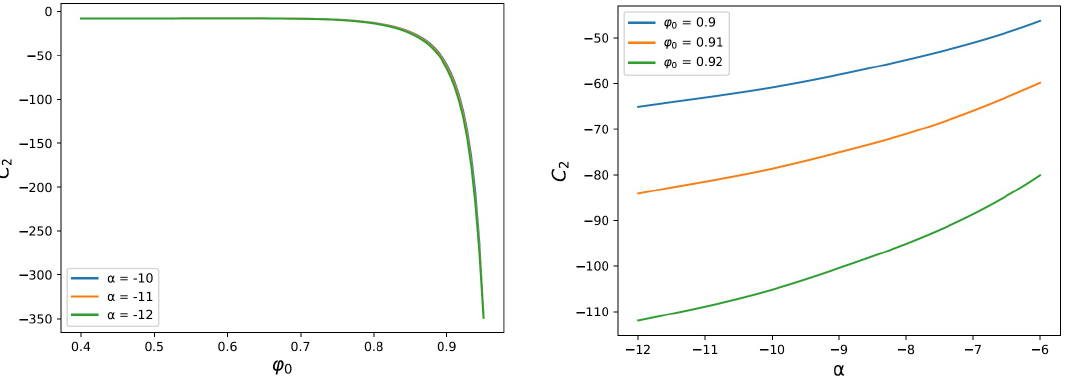
with respect to α for fixed values of ϕ 2